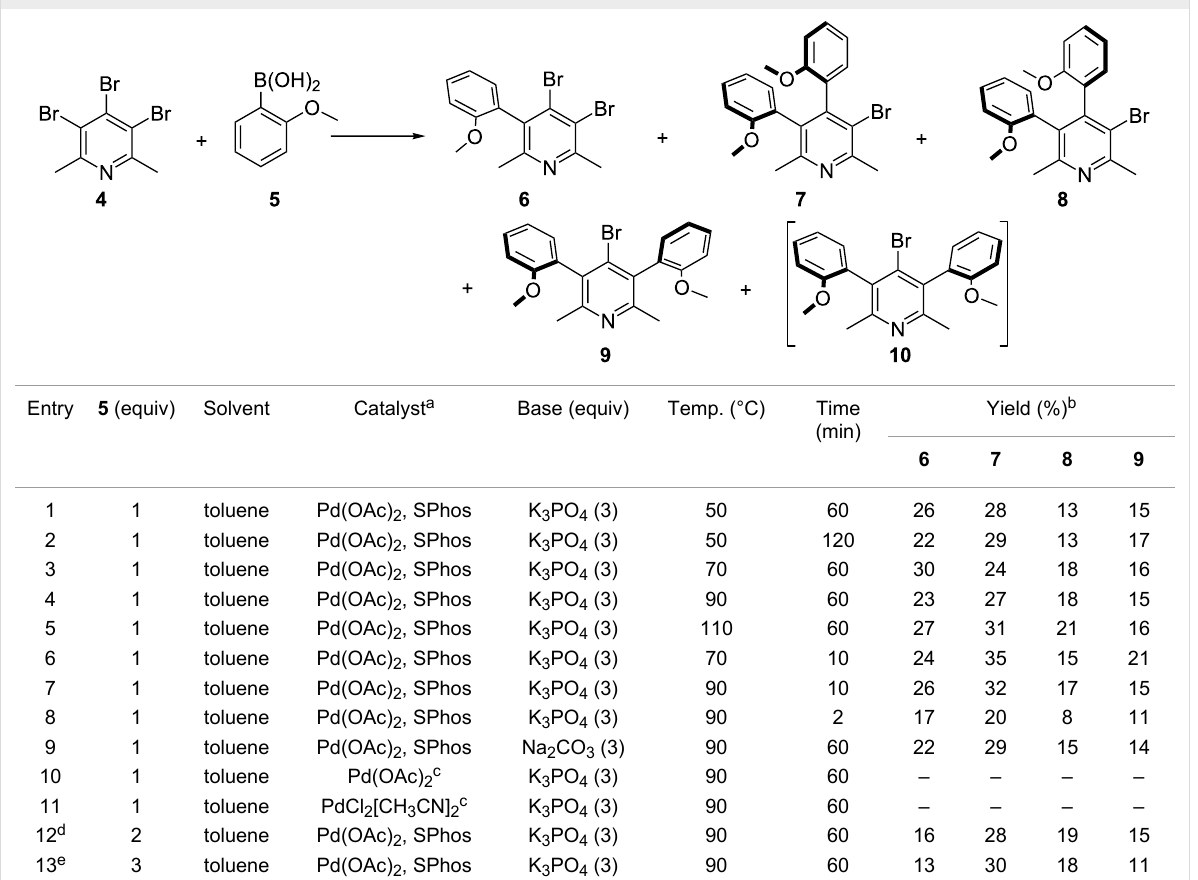
Table 1: Optimization for the synthesis 6 – 9 . Compound 10 was not detected in the